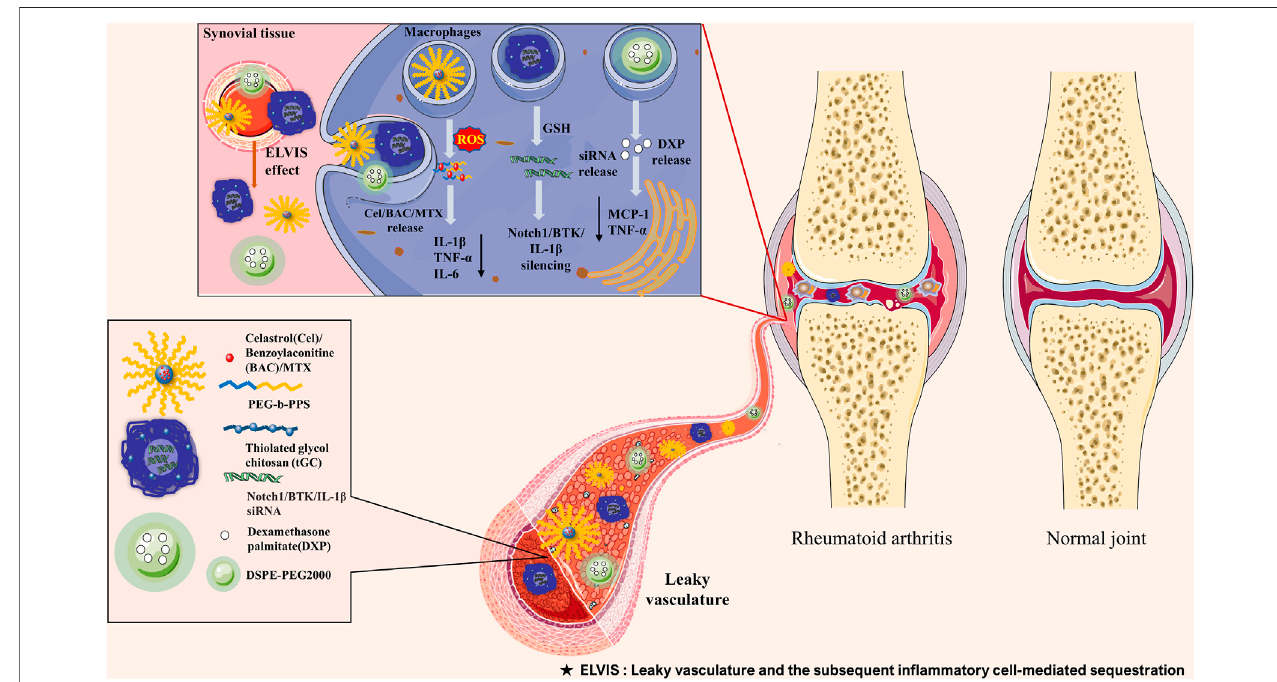
FIGURE 2 | Schematic illustration of the passive targeting delivery system for the management of rheumatoid arthritis by manipulating macrophages with nanocarriers encapsulating various therapeutic agents. Polymer nanoparticles, chitosan nanoparticles, and polymeric micelles have been used for the treatment of RA. Upon intravenous administration, nanoparticles accumulate in the in fl amed joints via the ELVIS effect. Subsequently, these nanoparticles are taken up by activated macrophages and selectively deliver Cel, BAC, MTX, DXP, and Notch1/BTK/IL-1 β siRNA through pH-responsive, redox-responsive, and ROS-responsive approaches. This process reduces the release of MCP-1, TNF- α , IL-1 β , and IL-6, thus alleviating the progression of RA. BAC, benzoylaconitine; BTK, Bruton ’ s tyrosine kinase; Cel, celastrol; DXP, dexamethasone palmitate; ELVIS,Extravasation through Leaky Vasculatureand the subsequent In fl ammatory cell – mediated Sequestration; GSH, glutathione; IL-1 β , interleukin-1 β ; IL-6, interleukin-6; MCP-1, monocyte chemoattractant protein-1; MTX, methotrexate; RA, rheumatoid arthritis; ROS, reactive oxygen species; siRNA, small interfering RNA; TNF- α , tumor necrosis factor α